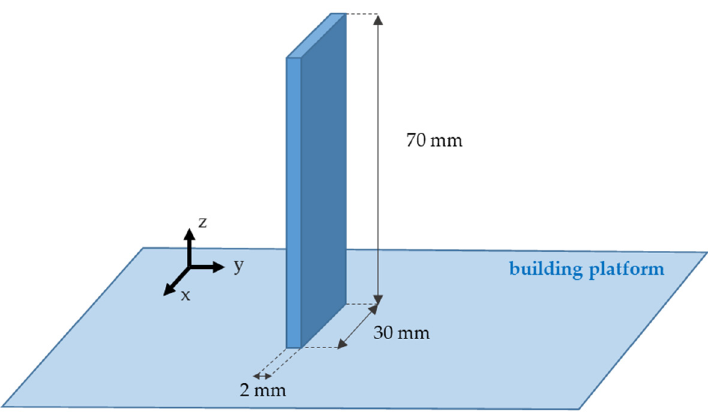
Figure 1. Sample size and diagram of the orientation of additive manufacturing (AM) samples on the building platform.